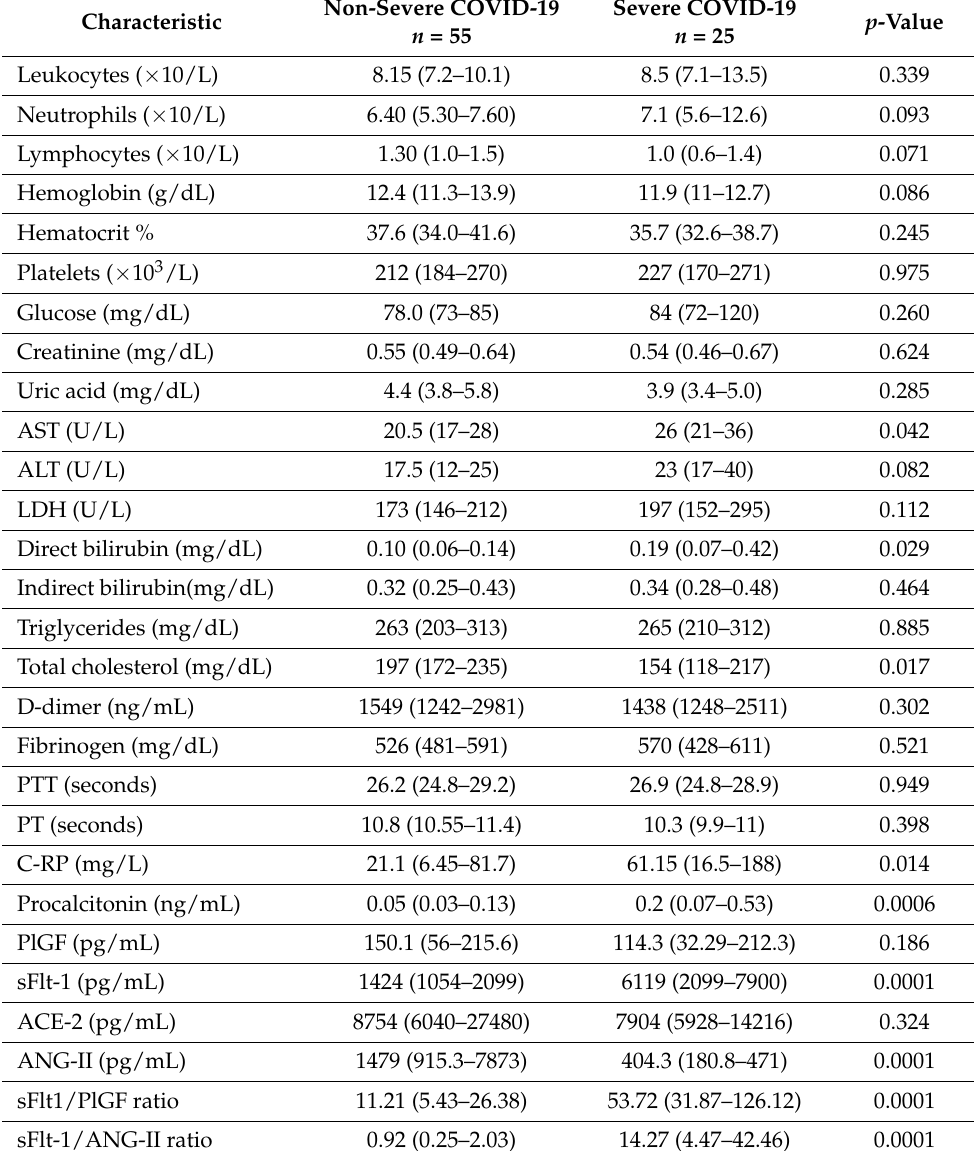
Table 2. Biochemical characteristics of the included